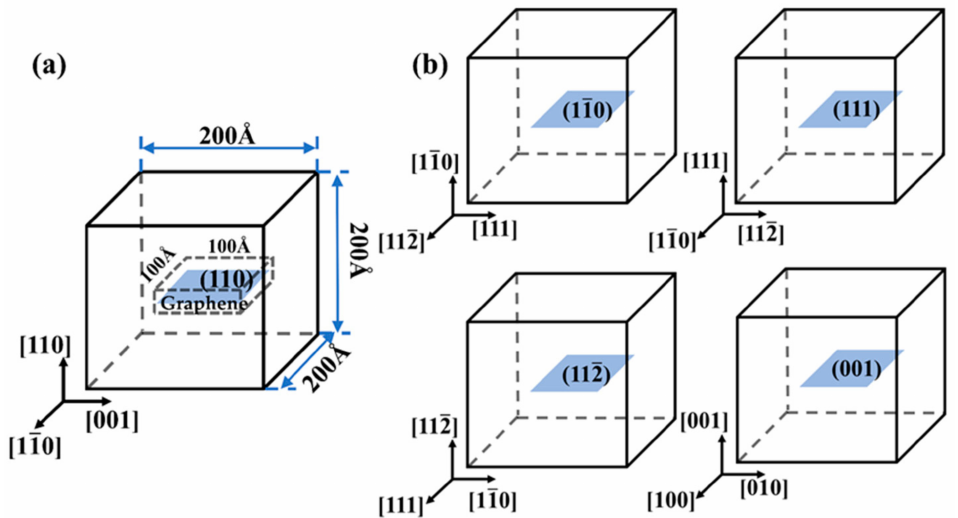
Figure 1. Schematic of molecular dynamic (MD) setting for the graphene nanosheet embedded into iron aligned along different crystallographic plane in the Gr/Fe composites: ( a ) (110) and ( b ) other four plane of (110), (111), (112) and (001),